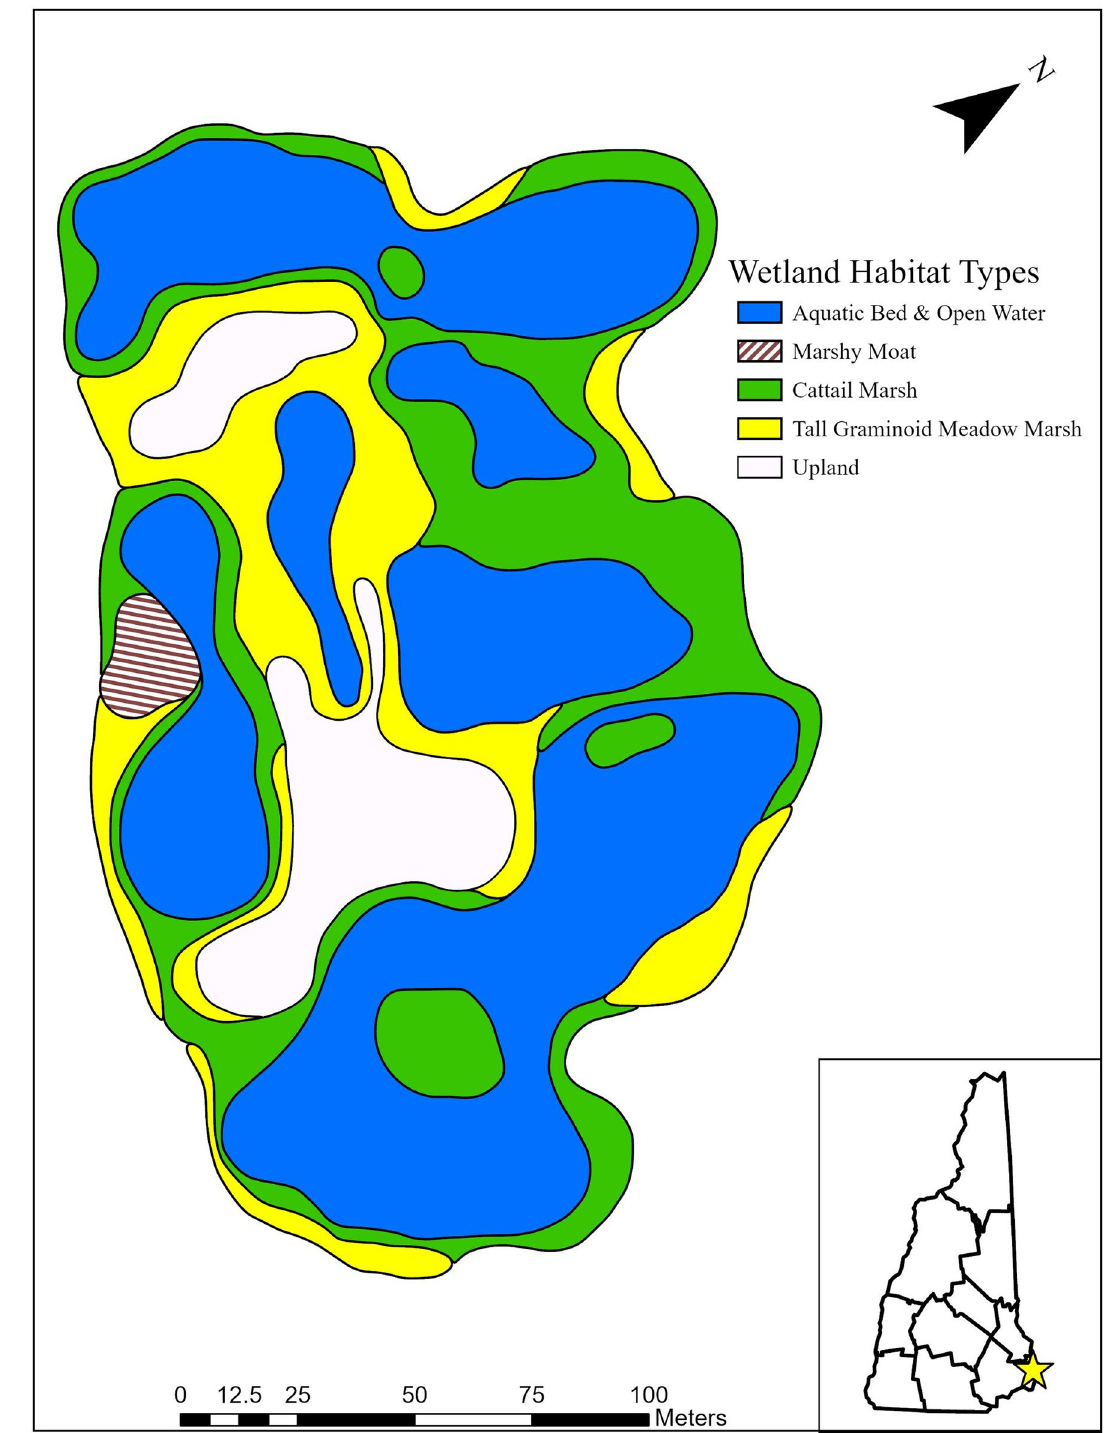
Fig 2. Wetland community distribution map of Quarry Pond in 1992 based on map and descriptions from Padgett and Crow 1994. Wetland community types were reclassified from dominant vegetation classification, georeferenced to drone imagery, and manually digitized in ArcGIS Pro. Wetland channels were not described in detail in